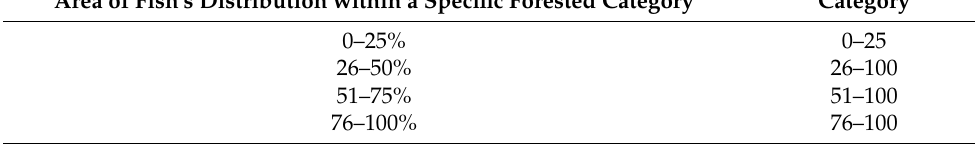
Table A2. Categories of fish species’ distribution. The lowest category is below 25% forested for each forested category above. The other categories are above 25%, above 50%, and above 75% of the HUC8s being forested.